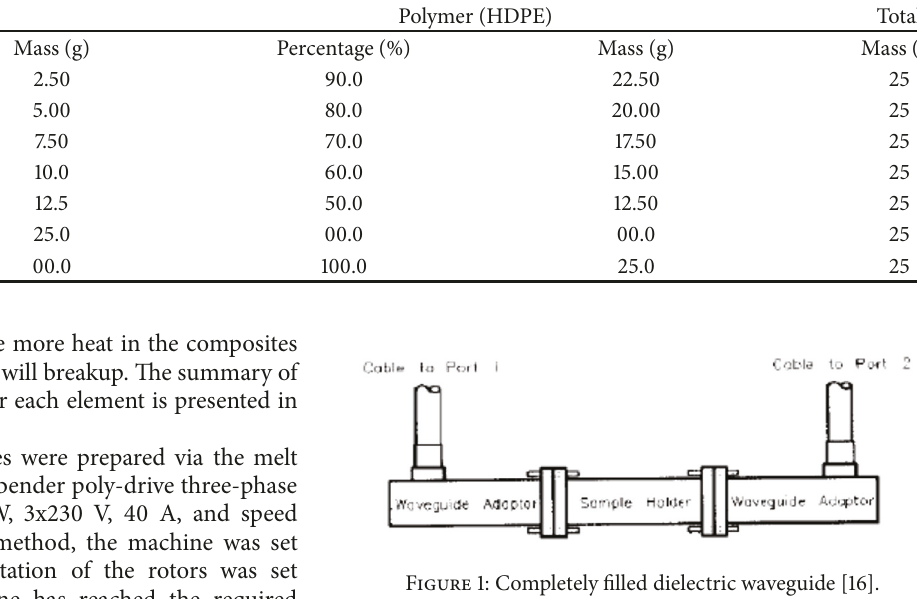
Figure 1: Completely filled dielectric waveguide